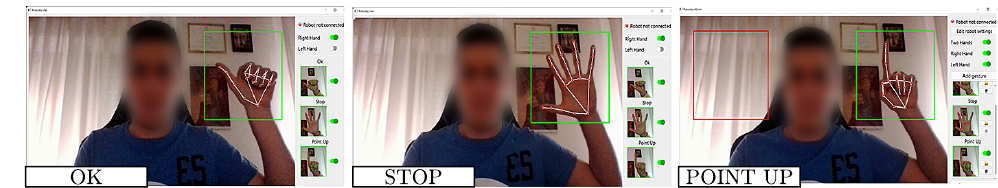
Figure 3. Example of gesture recognition using a standard webcam and Robotely software [32].